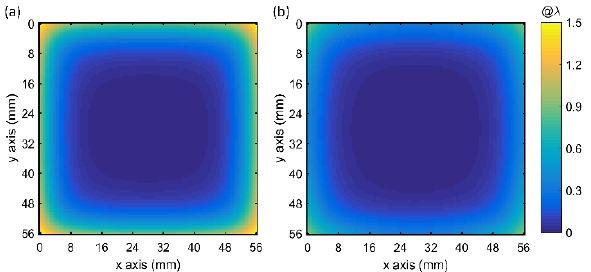
Figure 7. The calculated optical path difference (OPD) in the laser beam area of the gain slab ( a ) without and ( b ) with the absorbing cladding layer.